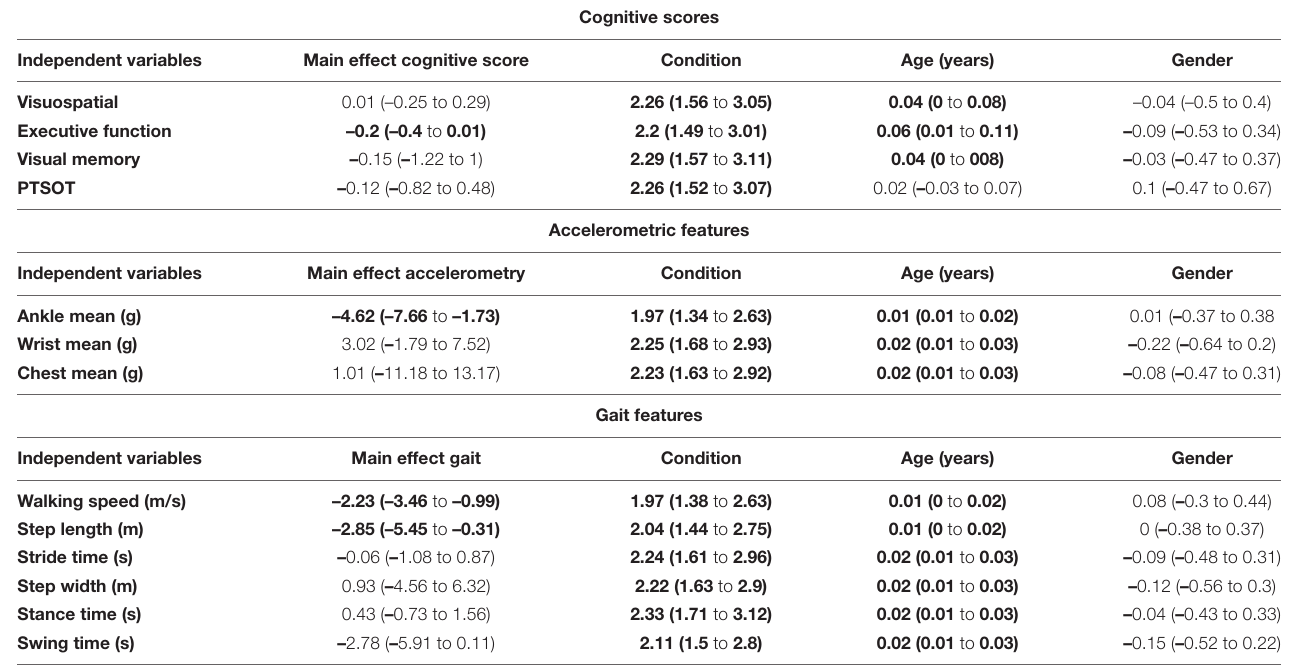
TABLE 2 | Number of disorientation events by cognitive, accelerometric, and gait